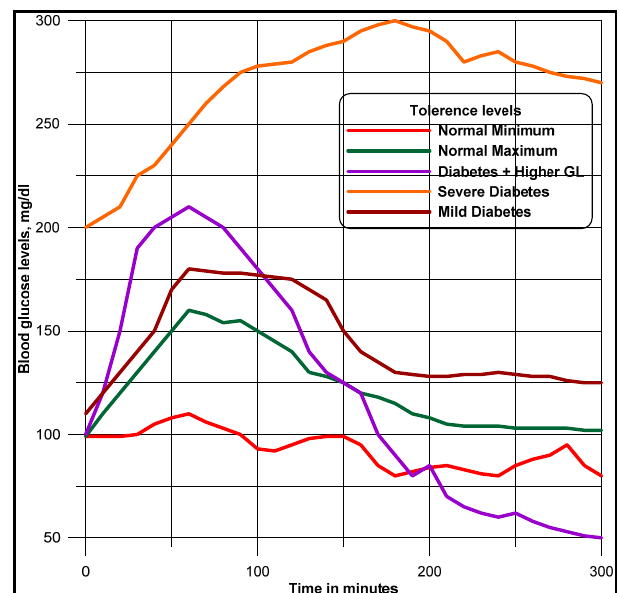
Figure 23. Blood glucose tolerance tests (5